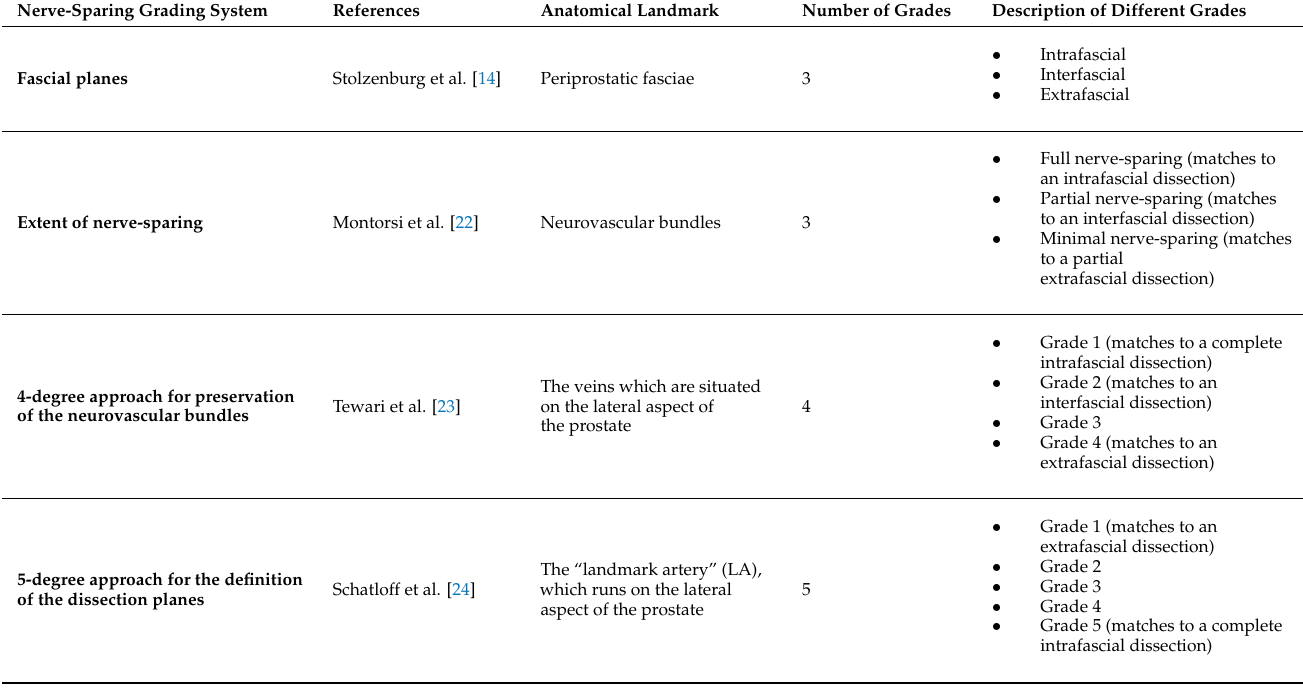
Table 1. Different nerve-sparing grading